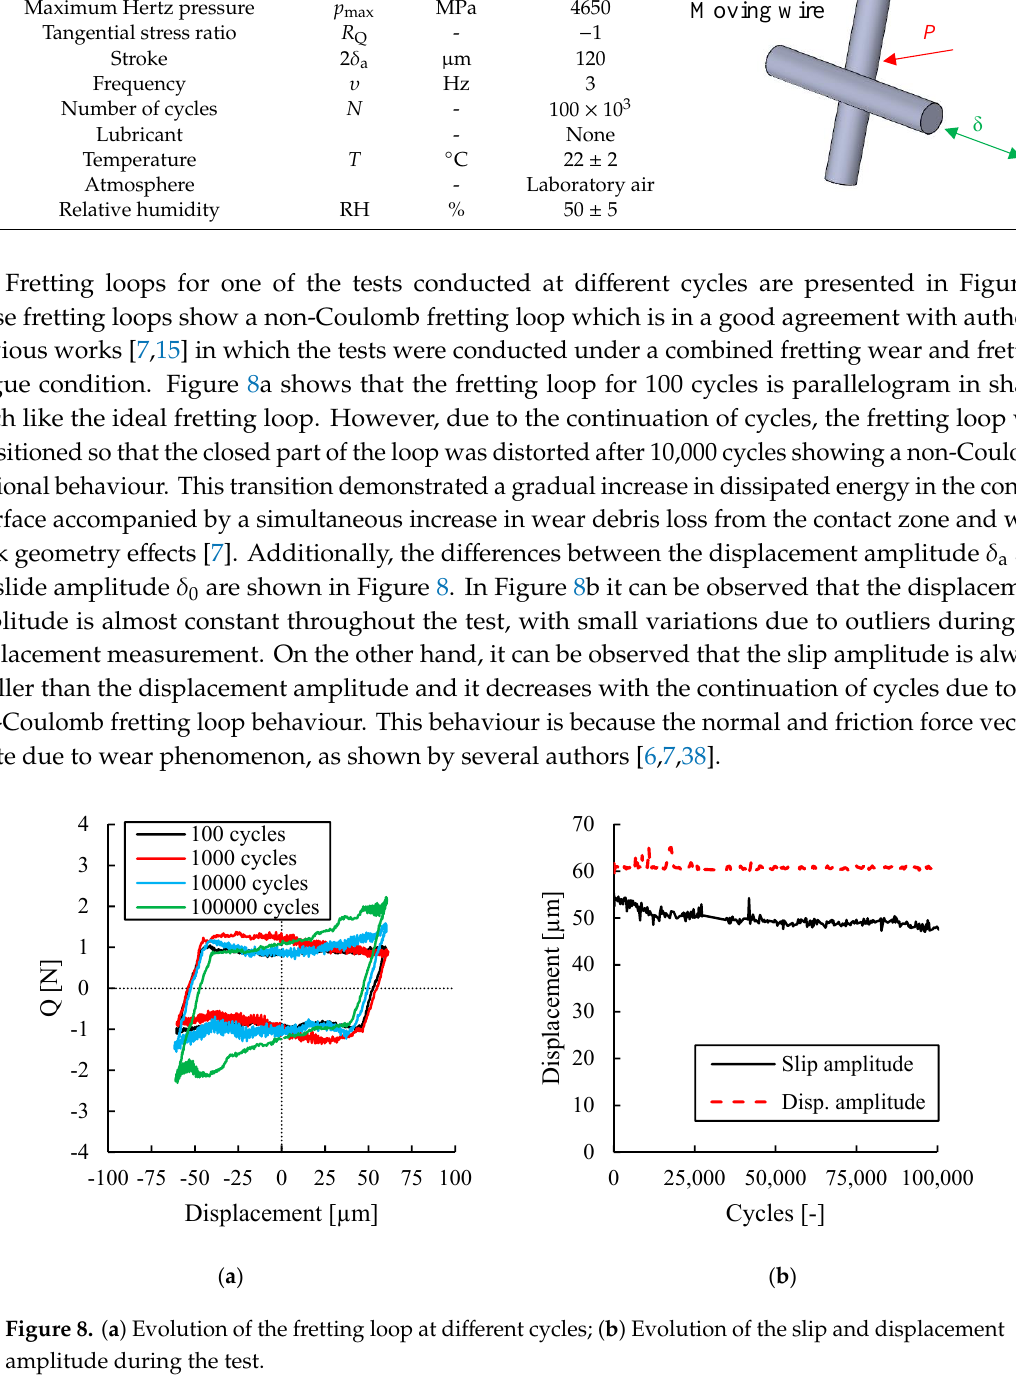
Table 1 . Fretting tribological test conditions. 306